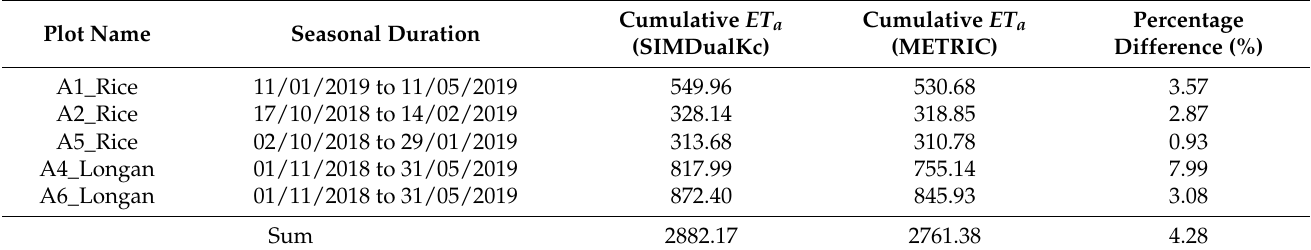
Table 5. Cumulative actual evapotranspiration ( ET a ) values derived from the mapping evapotran- spiration at high resolution with internalized calibration (METRIC) model and SIMDualKc for each sample plot in the testing area in the Chom Thong District, Chiang Mai Province, downstream of the Muang Luang Weir in Thailand, covering the dry season in